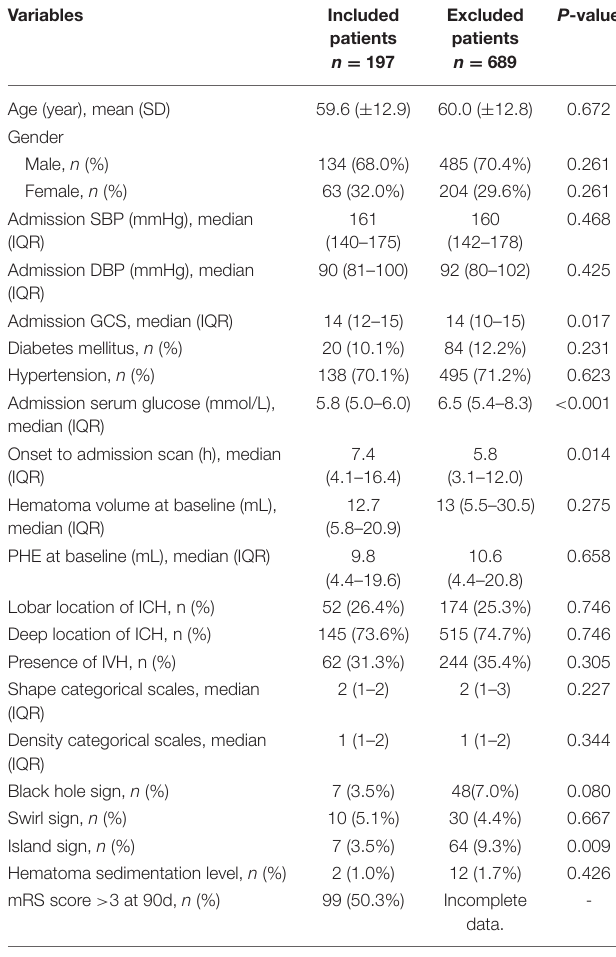
TABLE 1 | Demographics and ICH characteristics of included and excluded